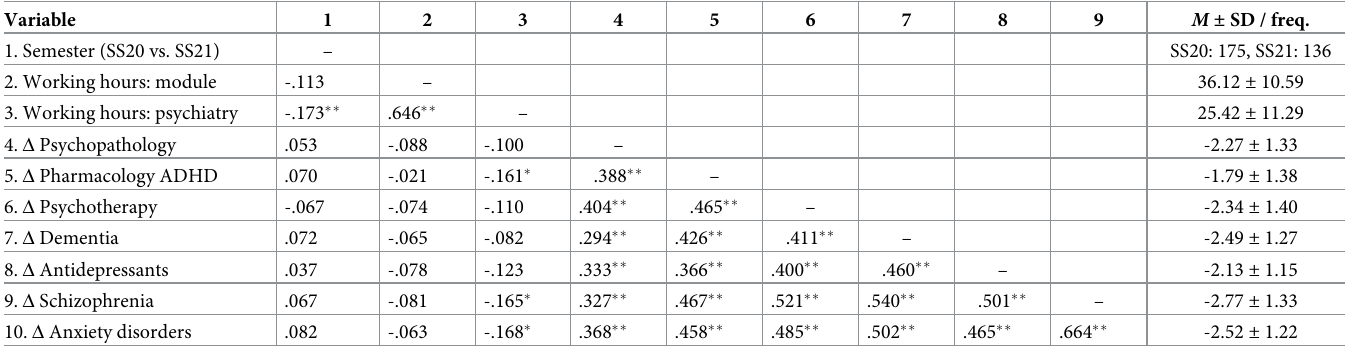
Table 2. Knowledge gain (SS20 vs.